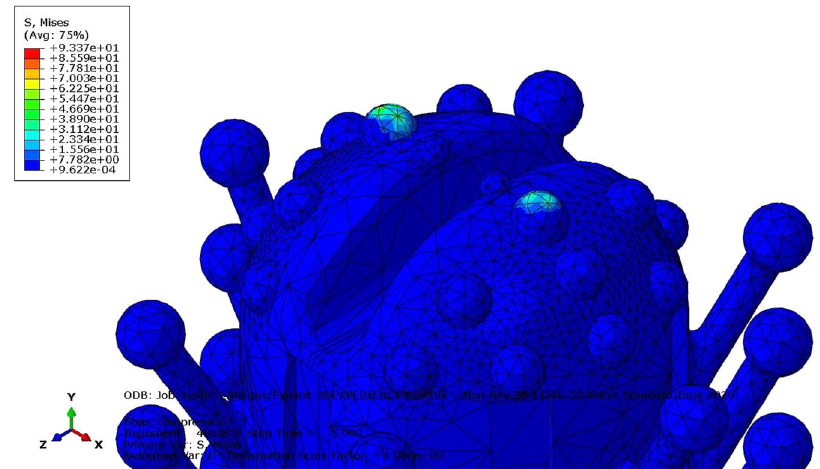
Fig. 4 Deformed swab and von Mises stress pro fi